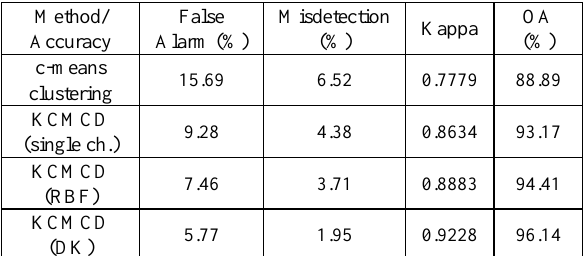
Table 1. Quantitative comparison of the results. KCMCD is abbreviation to kernel based c-means change